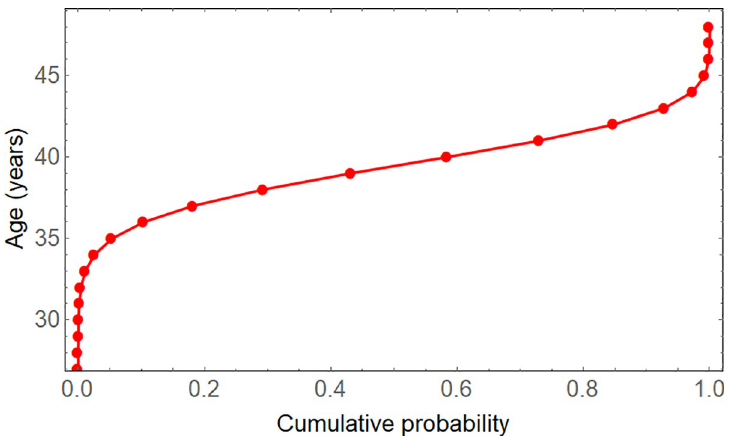
Fig 4. The inverse cumulative distribution function for boundary 48. The calculated probabilities are piecewise linearly connected to get a continuous function. It serves to find confidence limits for the estimated age, for a 95% confidence interval at 2.5% and 97.5%. The age goes downwards to 0, and the cumulative probability on the left also towards